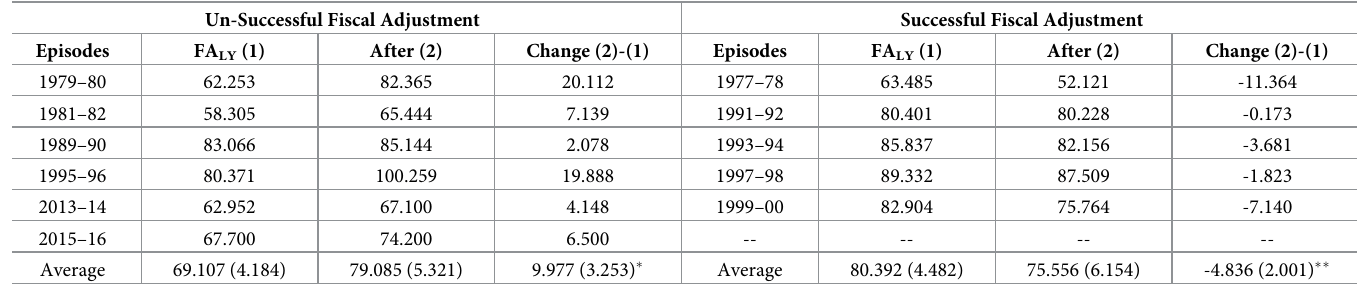
Table 2. Reduction in debt-to-GDP ratio (Definition-2).